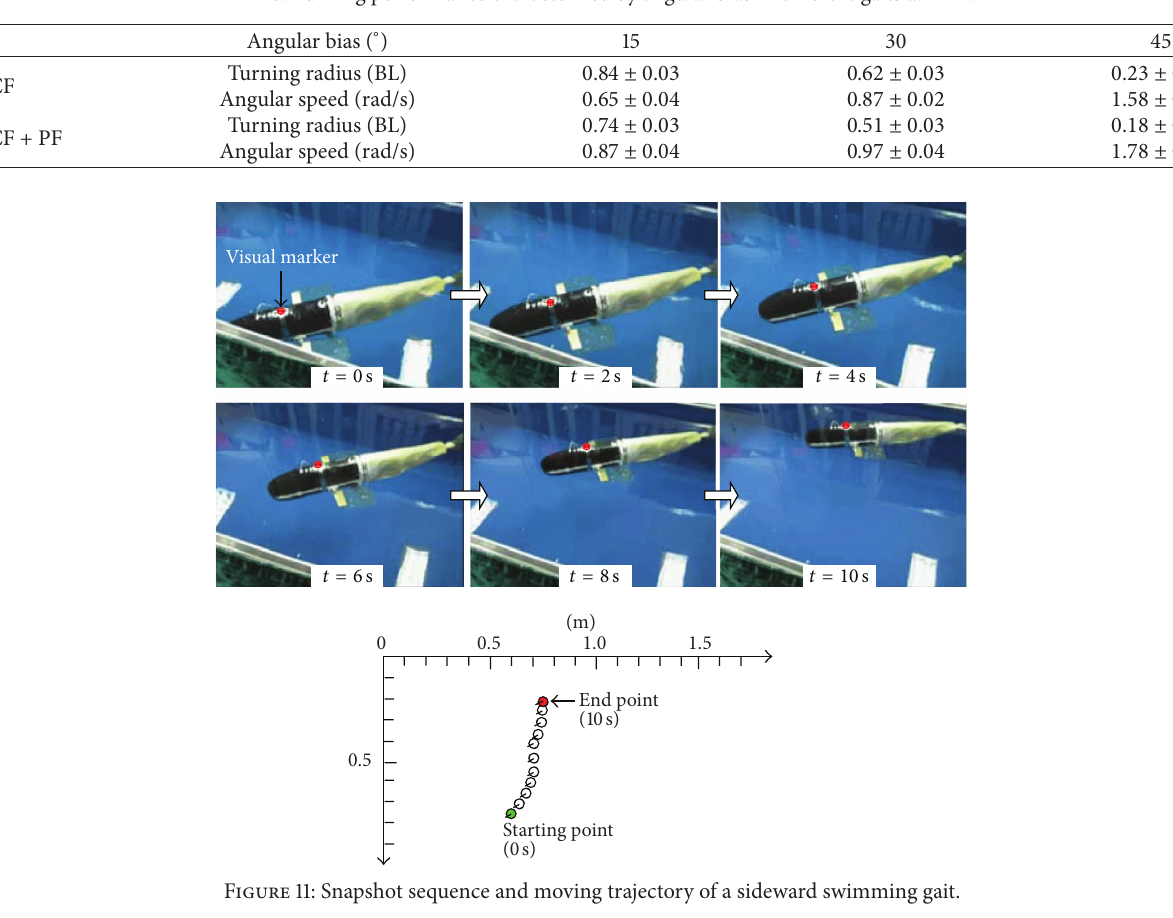
Table 3: Turning performance characterized by angular bias in different gaits at 2 Hz.